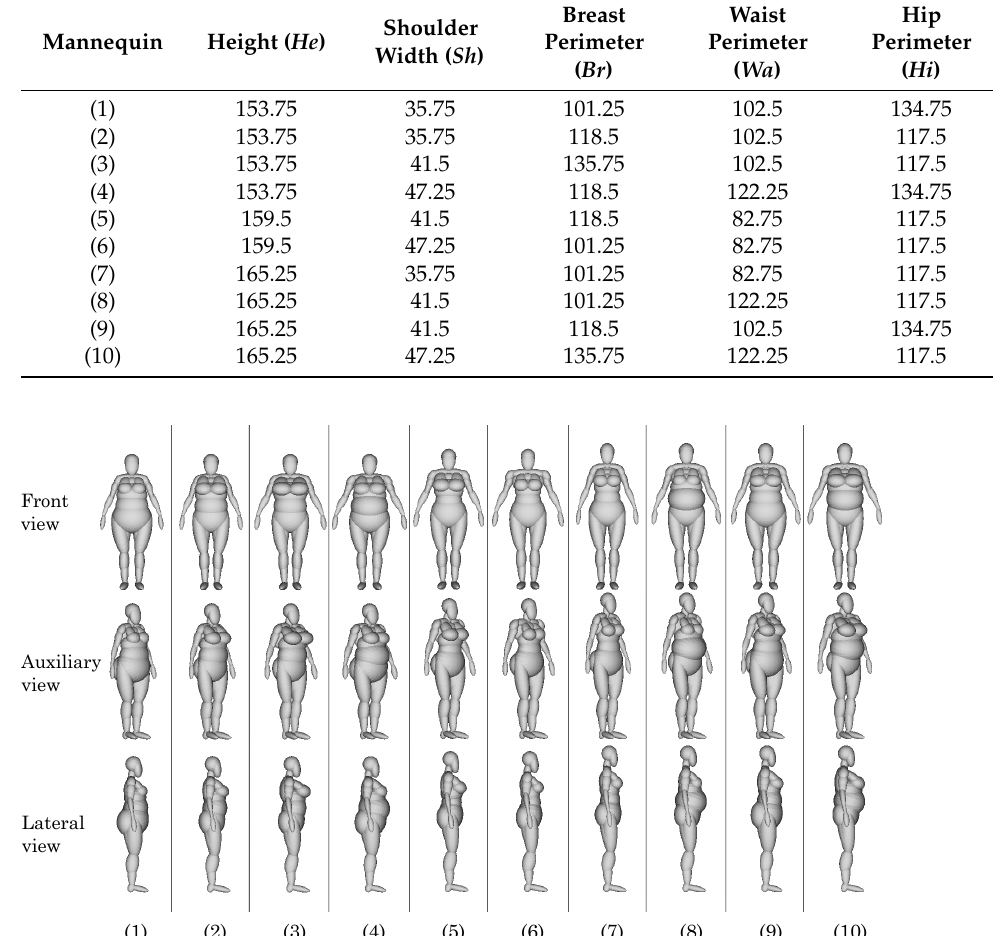
Table 5. Tailor measurements of mannequins shown in Figures 18 and 19. Measurements in cm.